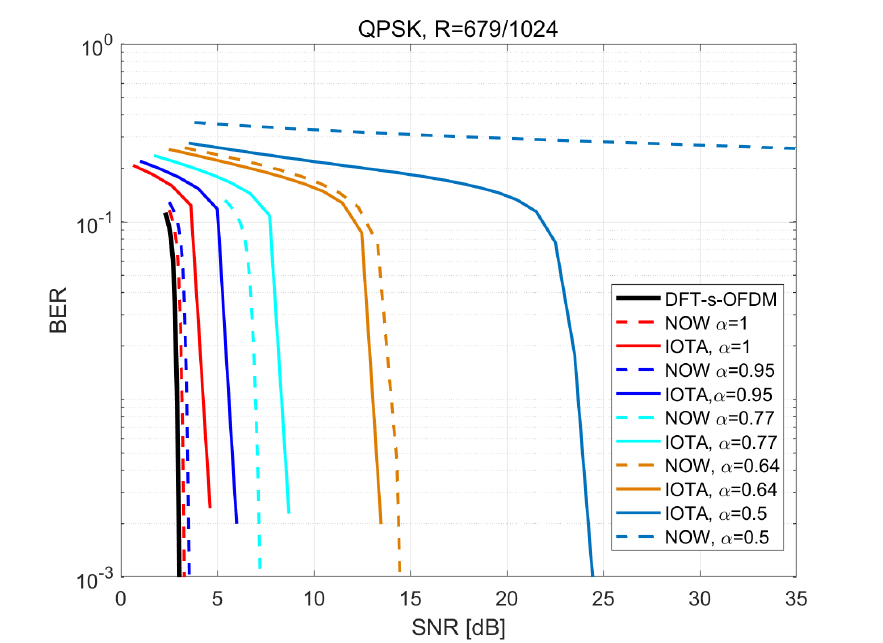
Figure 11. Performance of BER based on QPSK with R =